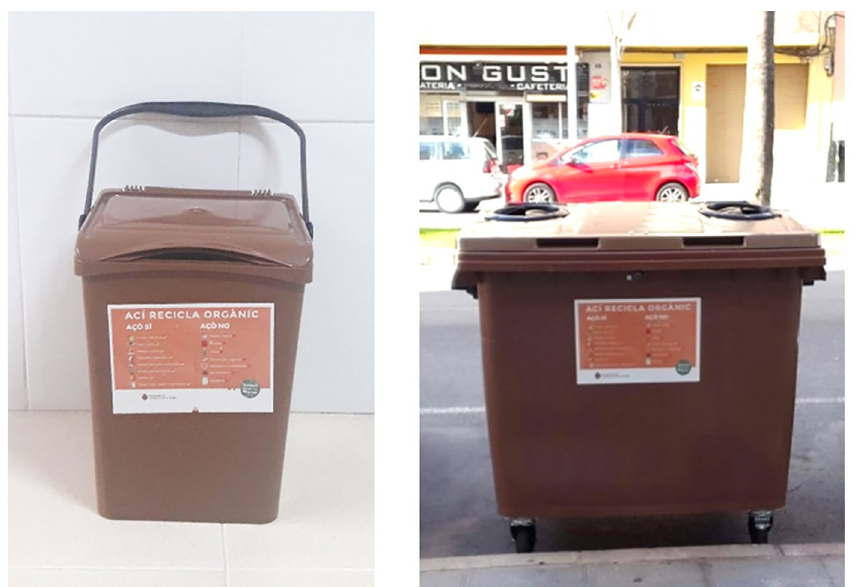
Figure 1. 10 L bin (left) and 1,100 L container